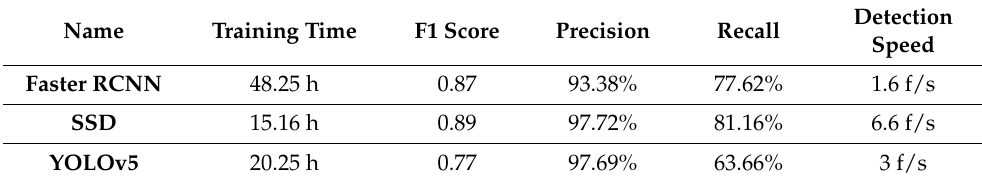
Table 2. Testing Results for testing data set one.